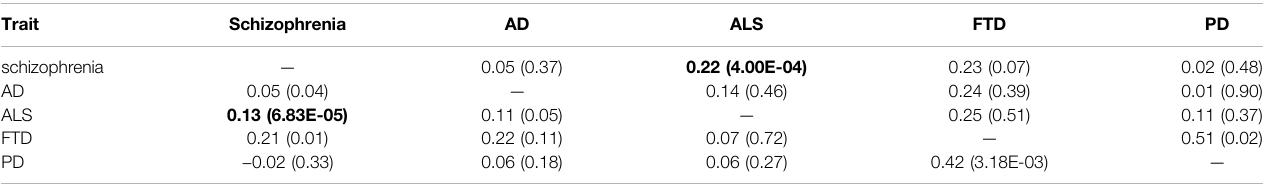
TABLE 1 | Genetic correlation between schizophrenia and four neurodegenerative disorders.